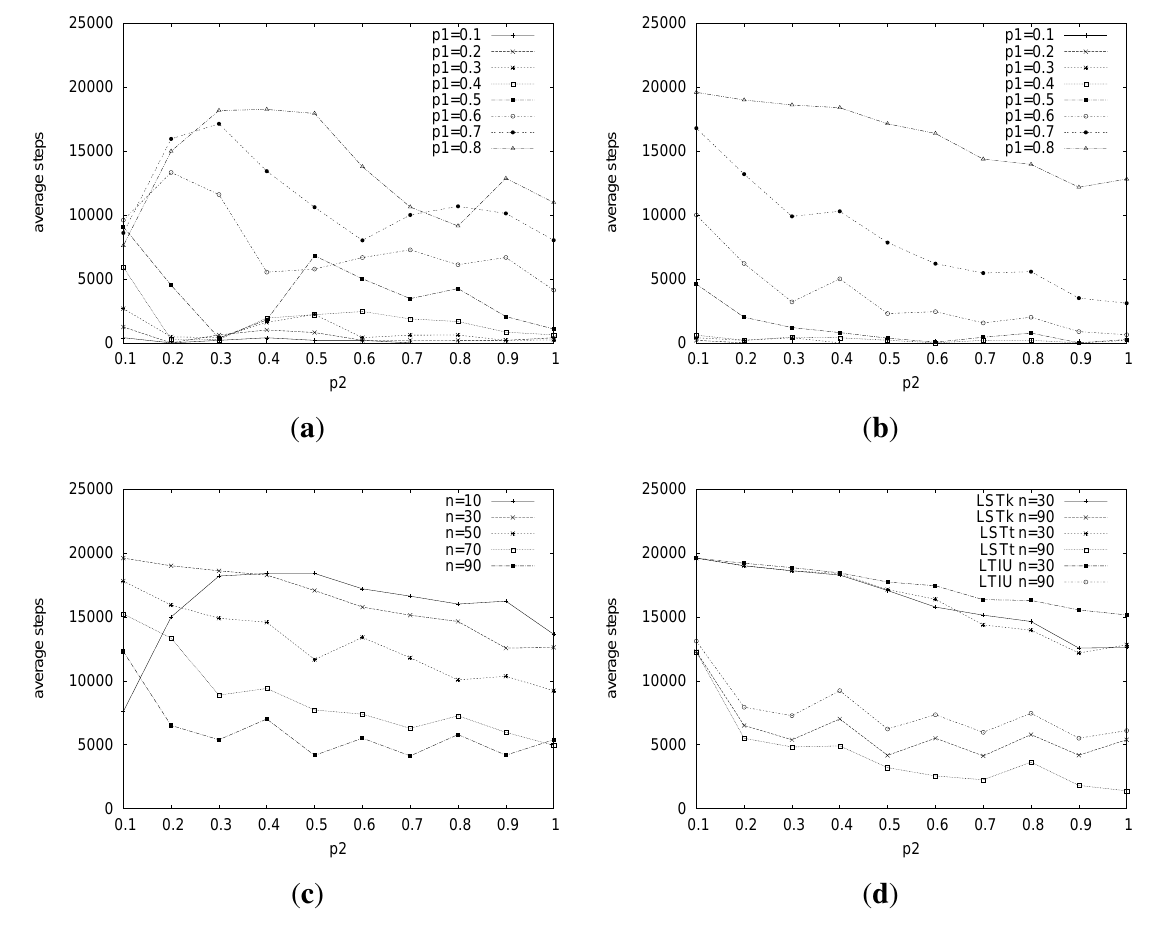
Figure 9. Average number of steps for LSTt, LSTk and LTIU. ( a ) Average number of steps for LSTt for n = 10; ( b ) average number of steps for LSTt for n = 30; ( c ) average number of steps for LSTt varying n and fixing p = 0.8; ( d ) average number of steps for LSTk, LSTt 1 and LTIU on problems of a size of 30 and 90. Fixing p = 0.8, k = 50% and t = 0 : 5 1